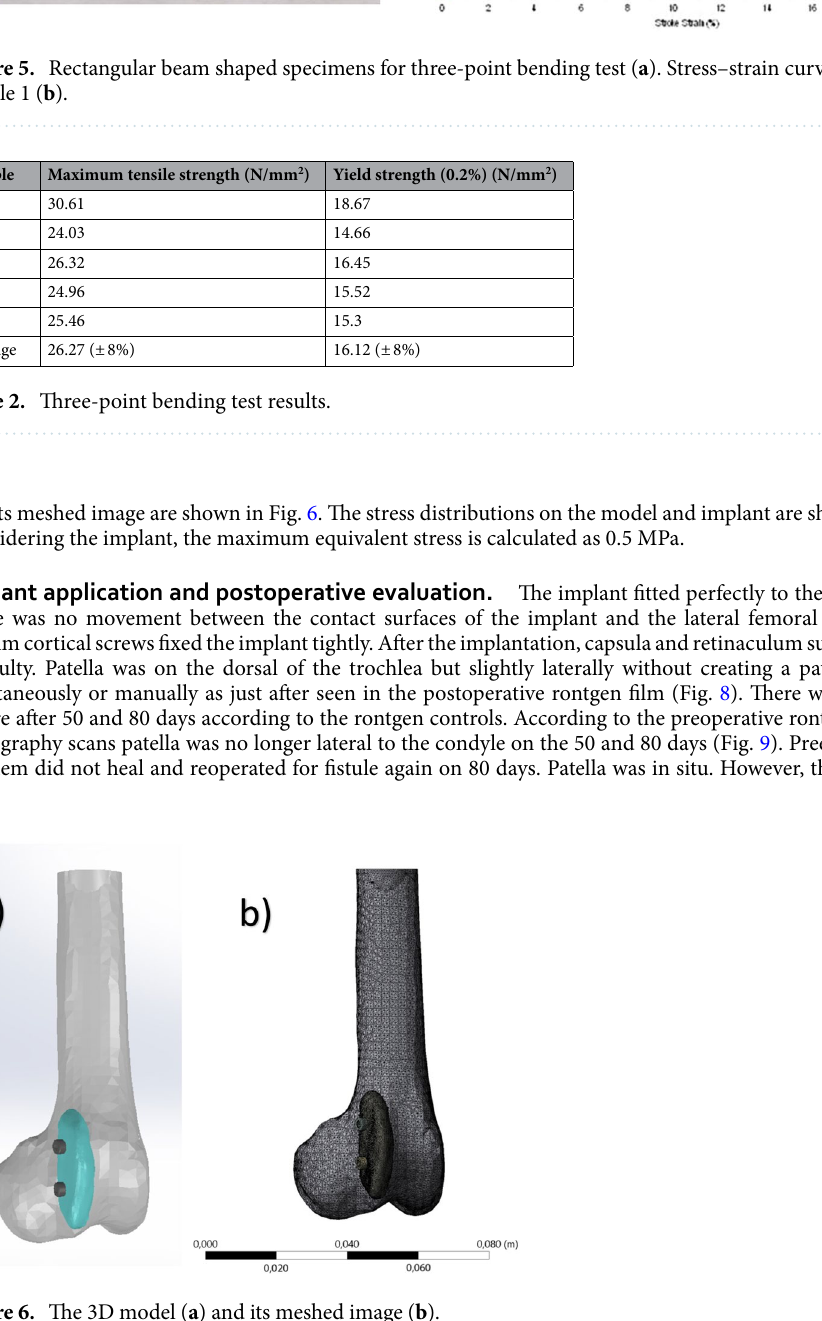
Figure 6. The 3D model ( a ) and its meshed image ( b